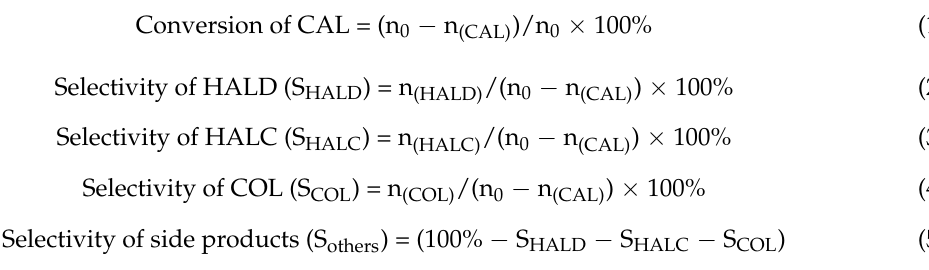
Table S1: Selective hydrogenation of cinnamaldehyde to hydrocinnamaldehyde over heterogeneous catalysts from the literature, Table S2: Details of the hydrogenation of CAL to HALD using Pd based catalysts, Figure S1: The pore size distributions calculated from the desorption using the BJH method for (a) SBA-15, (b) 0.2%Pd/SBA-15, (c) 0.2%Pd–0.4%Ni/SBA-15, (d) 0.2%Pd–0.7%Ni/SBA-15, (e) 0.2%Pd–1.2%Ni/SBA-15, Figure S2: Wide-angle XRD patterns of (a) 0.9%Pd/SBA-15, (b) 0.9%Pd–0.4%Ni/SBA-15, (c) 0.9%Pd–0.7%Ni/SBA-15, (d) 0.9%Pd–1.2%Ni/SBA-15, Figure S3: TEM images of (a–b) 0.9%Pd/SBA-15, (c–d) 0.9%Pd–1.2%Ni/SBA-15, Figure S4: Low-angle XRD patterns for the fresh and reused 0.2%Pd–1.2%Ni/SBA-15 catalyst, Figure S5: Wide-angle XRD patterns for the fresh and reused 0.2%Pd–1.2%Ni/SBA-15 catalyst, Figure S6: Pd3d XPS spectra for the fresh and reused 0.2%Pd–1.2%Ni/SBA-15